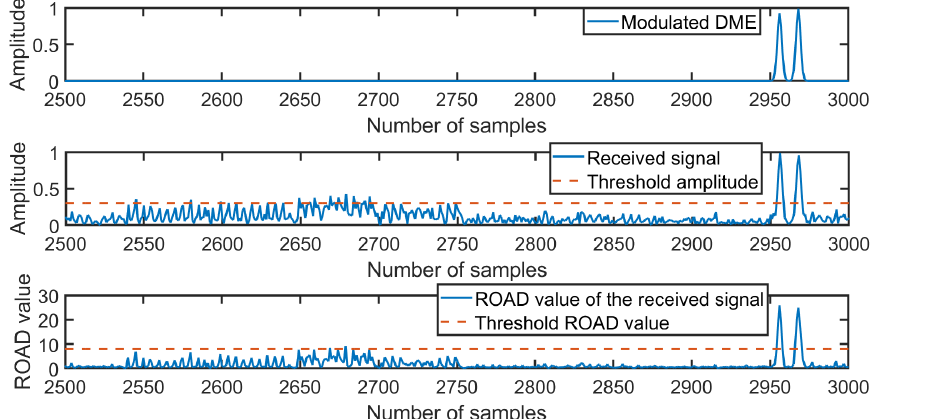
Figure 11. DME interference ( Top ), amplitude of the received signal without interference mitigation ( Middle ) and ROAD value of the received signal ( Bottom ) for an SNR of 15